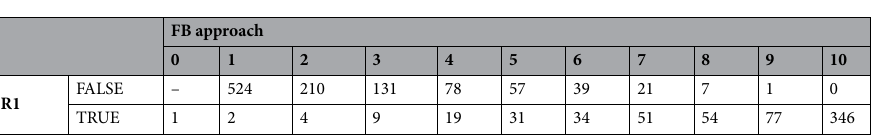
Table 1. Comparison of genes selected as differentially expressed in true technical replicate R1 (TRUE=gene was selected by adjusted it p value and log2 Fold Change; FALSE=gene was not selected) and in 0, 1, ..., 10 runs with artificially generated technical replicates by the FB approach. Of 628 genes selected from the R1 data, only 346 genes were selected in all 10 runs of the FB approach.